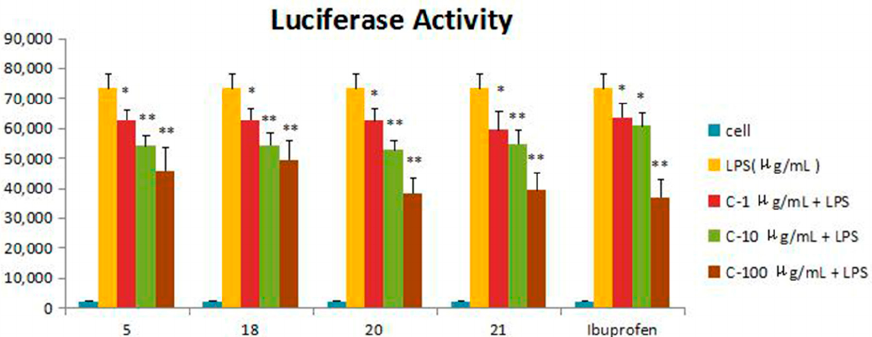
Figure 3. Inhibitory effects of Compounds 5 , 18 , 20 and 21 (1, 10, 100 μ g/mL) on NF- κ B in the luciferase activity assay. Data are expressed as the mean ± S.E.M. of three independent experiments. Cell: cultures were not exposed to lipopolysaccharide (LPS); LPS: cultures were subjected to LPS; LPS + Drug: compounds were added to the cultures during LPS; Positive control: LPS + Ibuprofen. ∗ p < 0.05 vs. LPS; ∗∗ p < 0.01 vs. LPS.